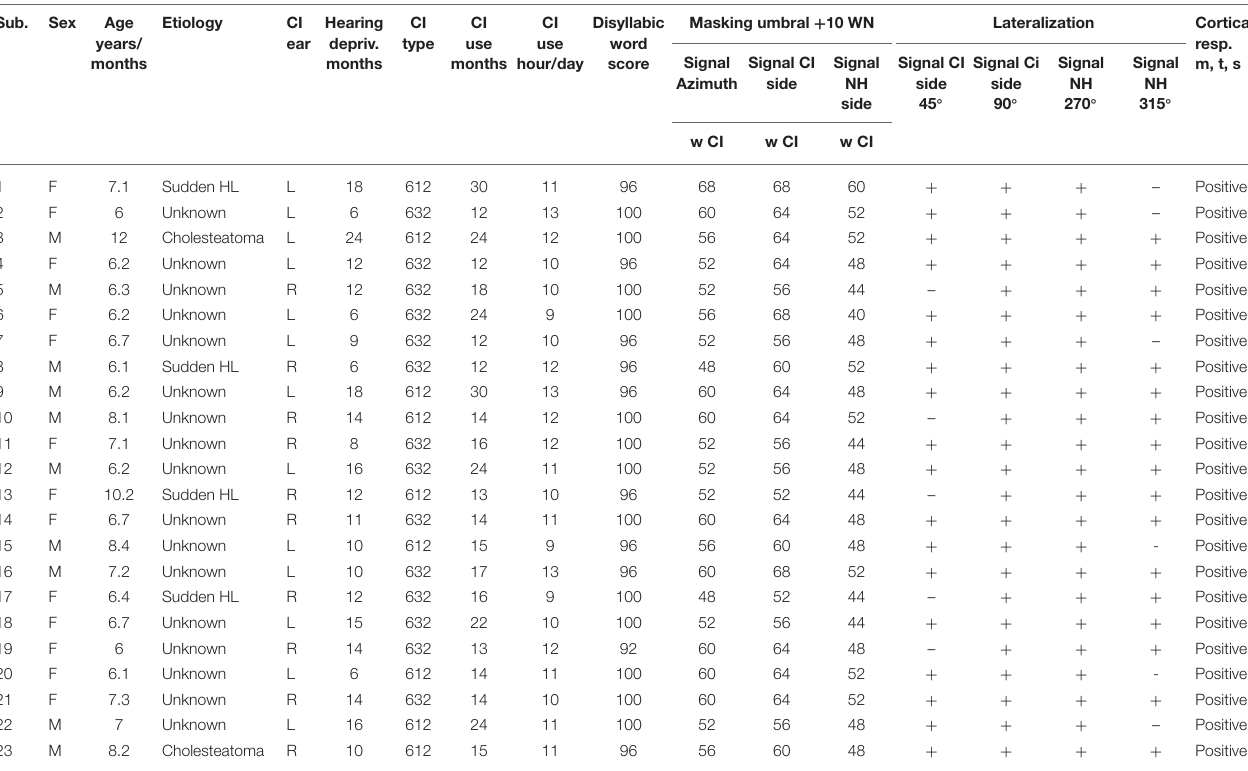
TABLE 1 | Characteristics and results of children the single-sided deafness children group. Sub.